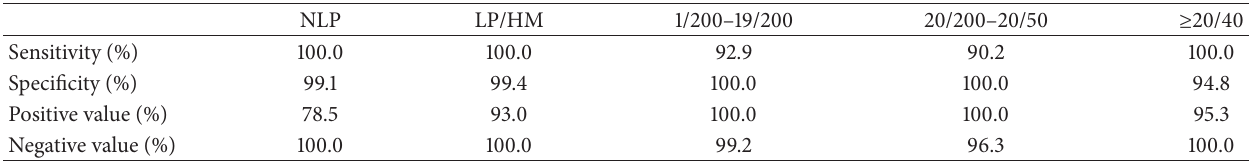
Table 6: The sensitivity and specificity of OTS in predicting the final